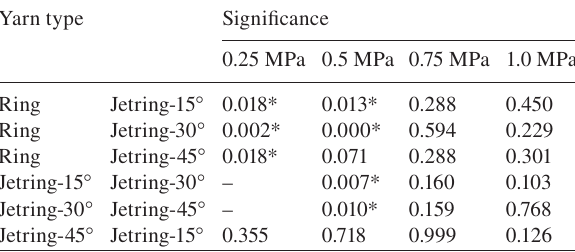
Table 10 ANOVA test results of yarn